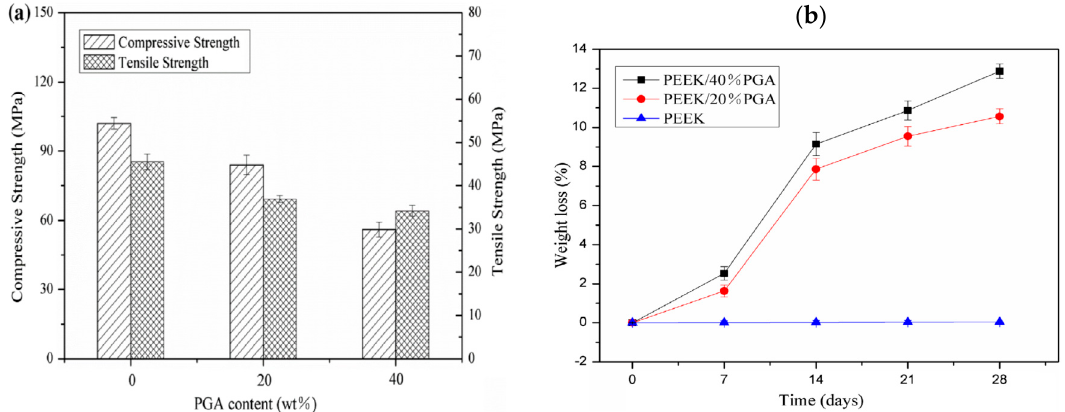
Figure 31. ( a ) Mechanical strength vs PGA content of SLS-printed PEEK and PEEK/PGA blend scaffolds. ( b ) Weight loss vs time plots of SLS-printed PEEK and PEEK/PGA blend scaffolds immersed in a simulated body fluid at 37 °C for different time periods. Reproduced from [219] with permission of Taylor & Francis.